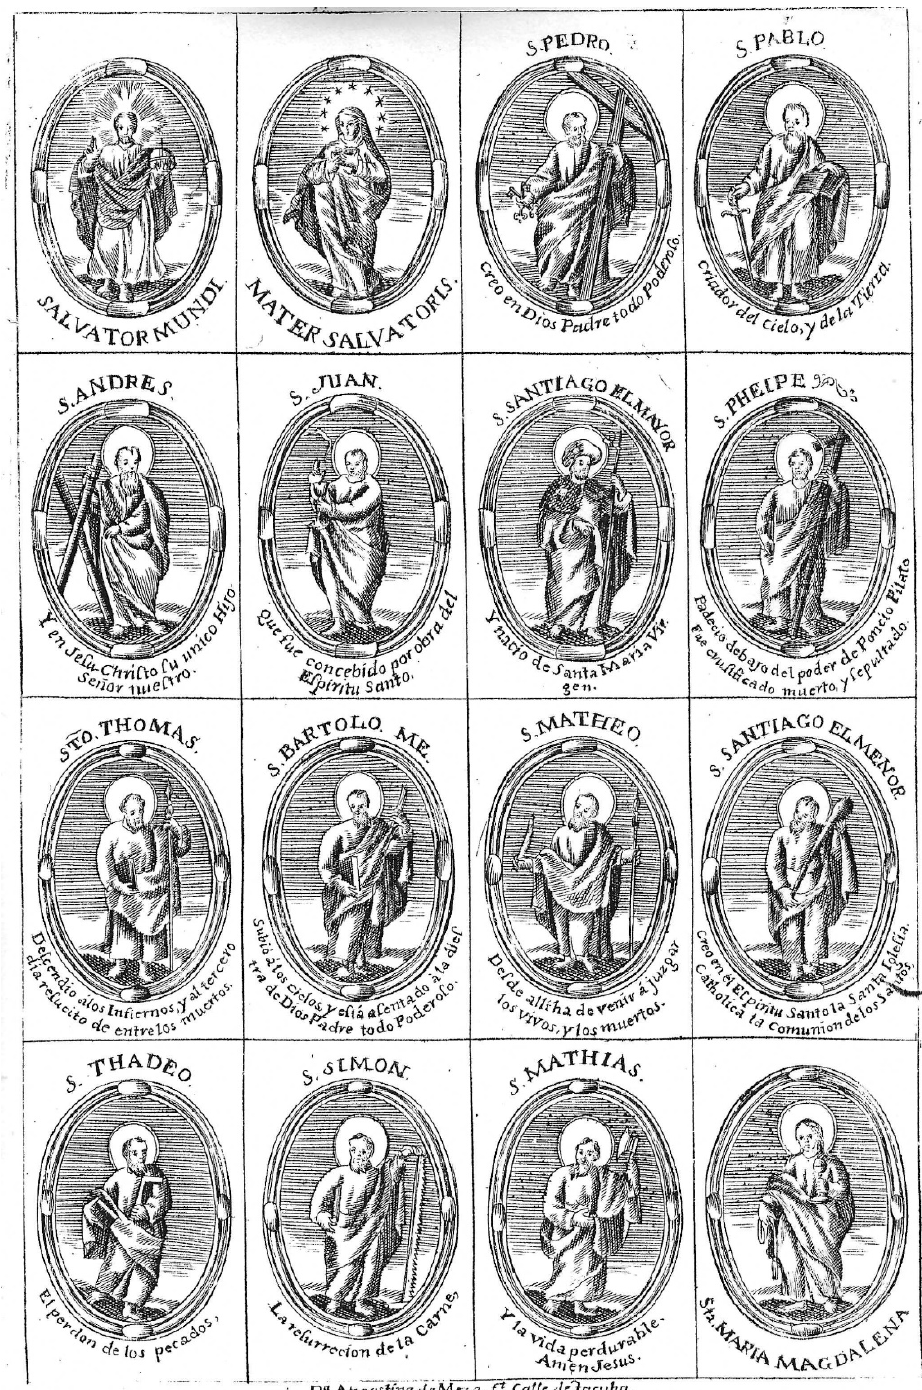
Figure 1. Augustina Meza, Christ, Mary, and the Apostles , ca. 1770. Engraving. Photograph by the author.